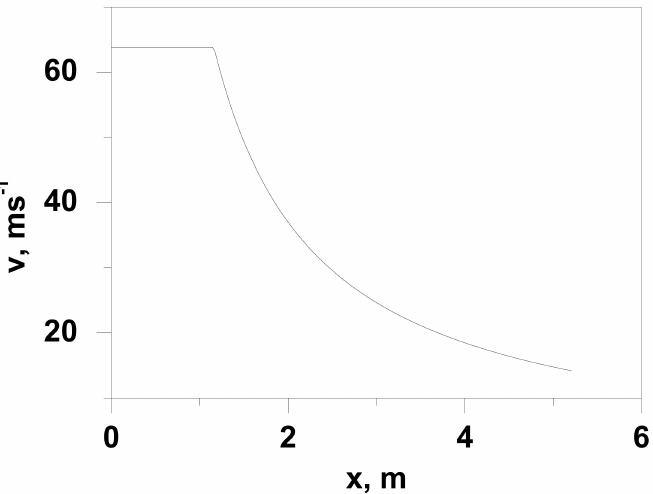
Figure 14. Jet velocity vs. axial distance in the range controlled by the free jet. Atmospheric conditions of the measurement series 4: T = 20.7 ◦ C, v = 0.57 m/s, RH = 53%, p = 1002.8 hPa. Release parameters: Q = 1.78 kg/s, p out = 6.1 atm, t = 243 s, h = 0.75